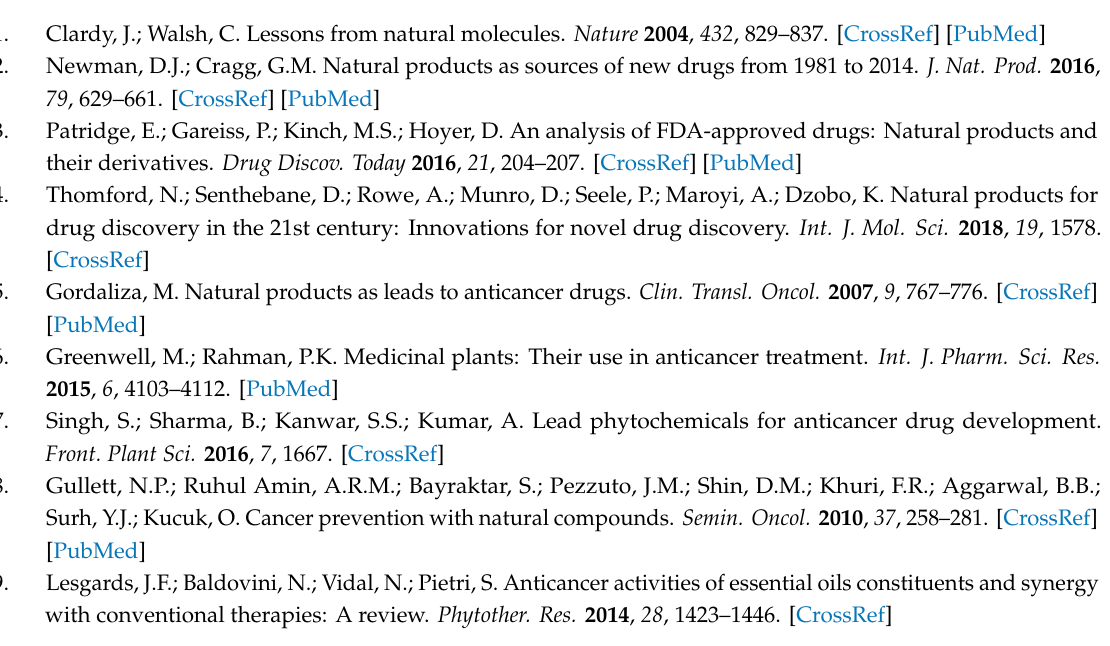
Figure S1: HPLC analysis; Table S1: RT-qPCR primers; Table S2: Ames test for mutagenic analysis; Table S3: Ames test for mutagen-protective